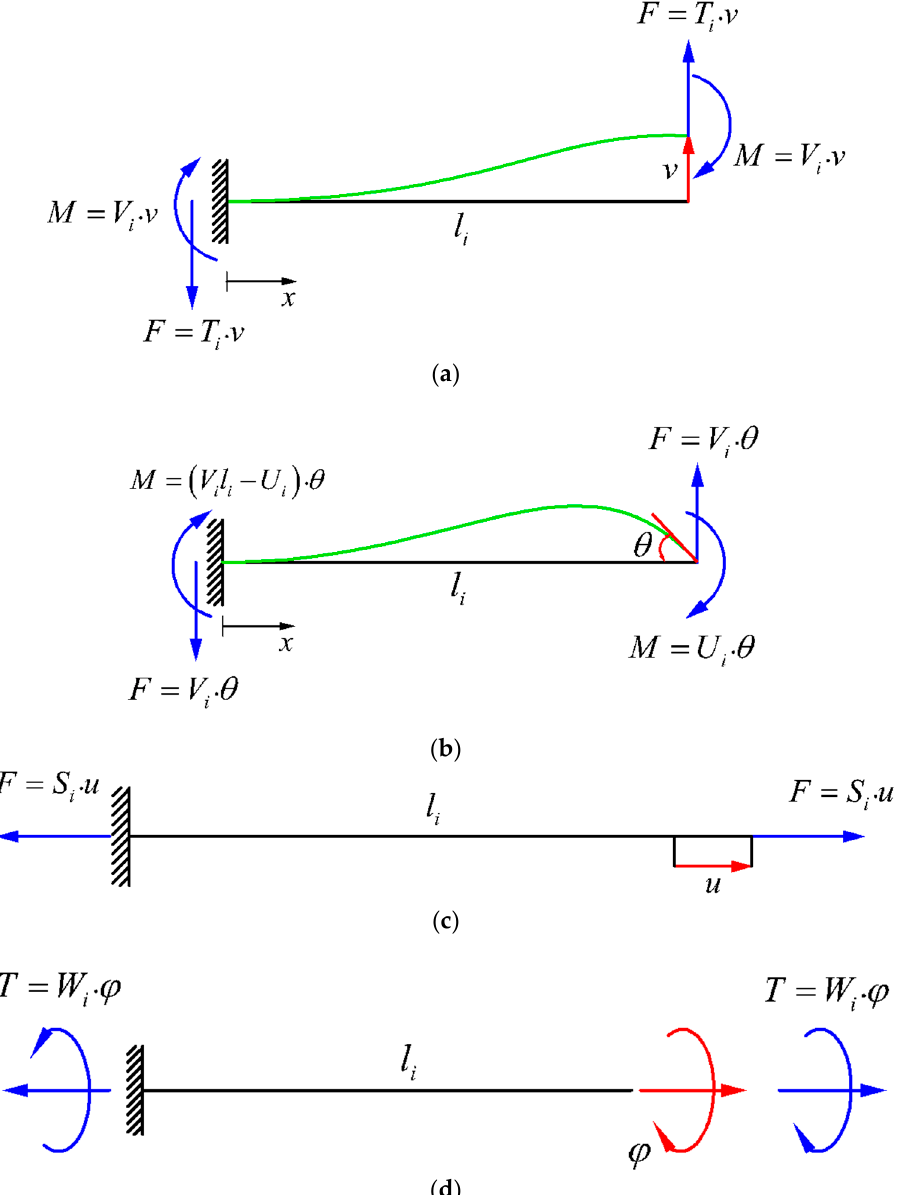
Figure 4. Forces and moments required to cause ( a ) lateral displacement 𝛿 with no rotation, ( b ) flexural rotation 𝜃 with no lateral displacement, ( c ) pure axial extension, and ( d ) pure twist at the free end of a beam [58]. Table 1. Parameters defined for summarizing the relationships for Euler–Bernoulli and Timo- shenko beam theories.